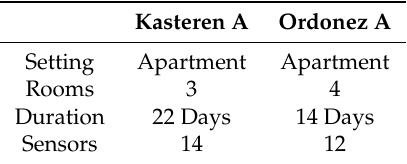
Table 4. Home setting and description.